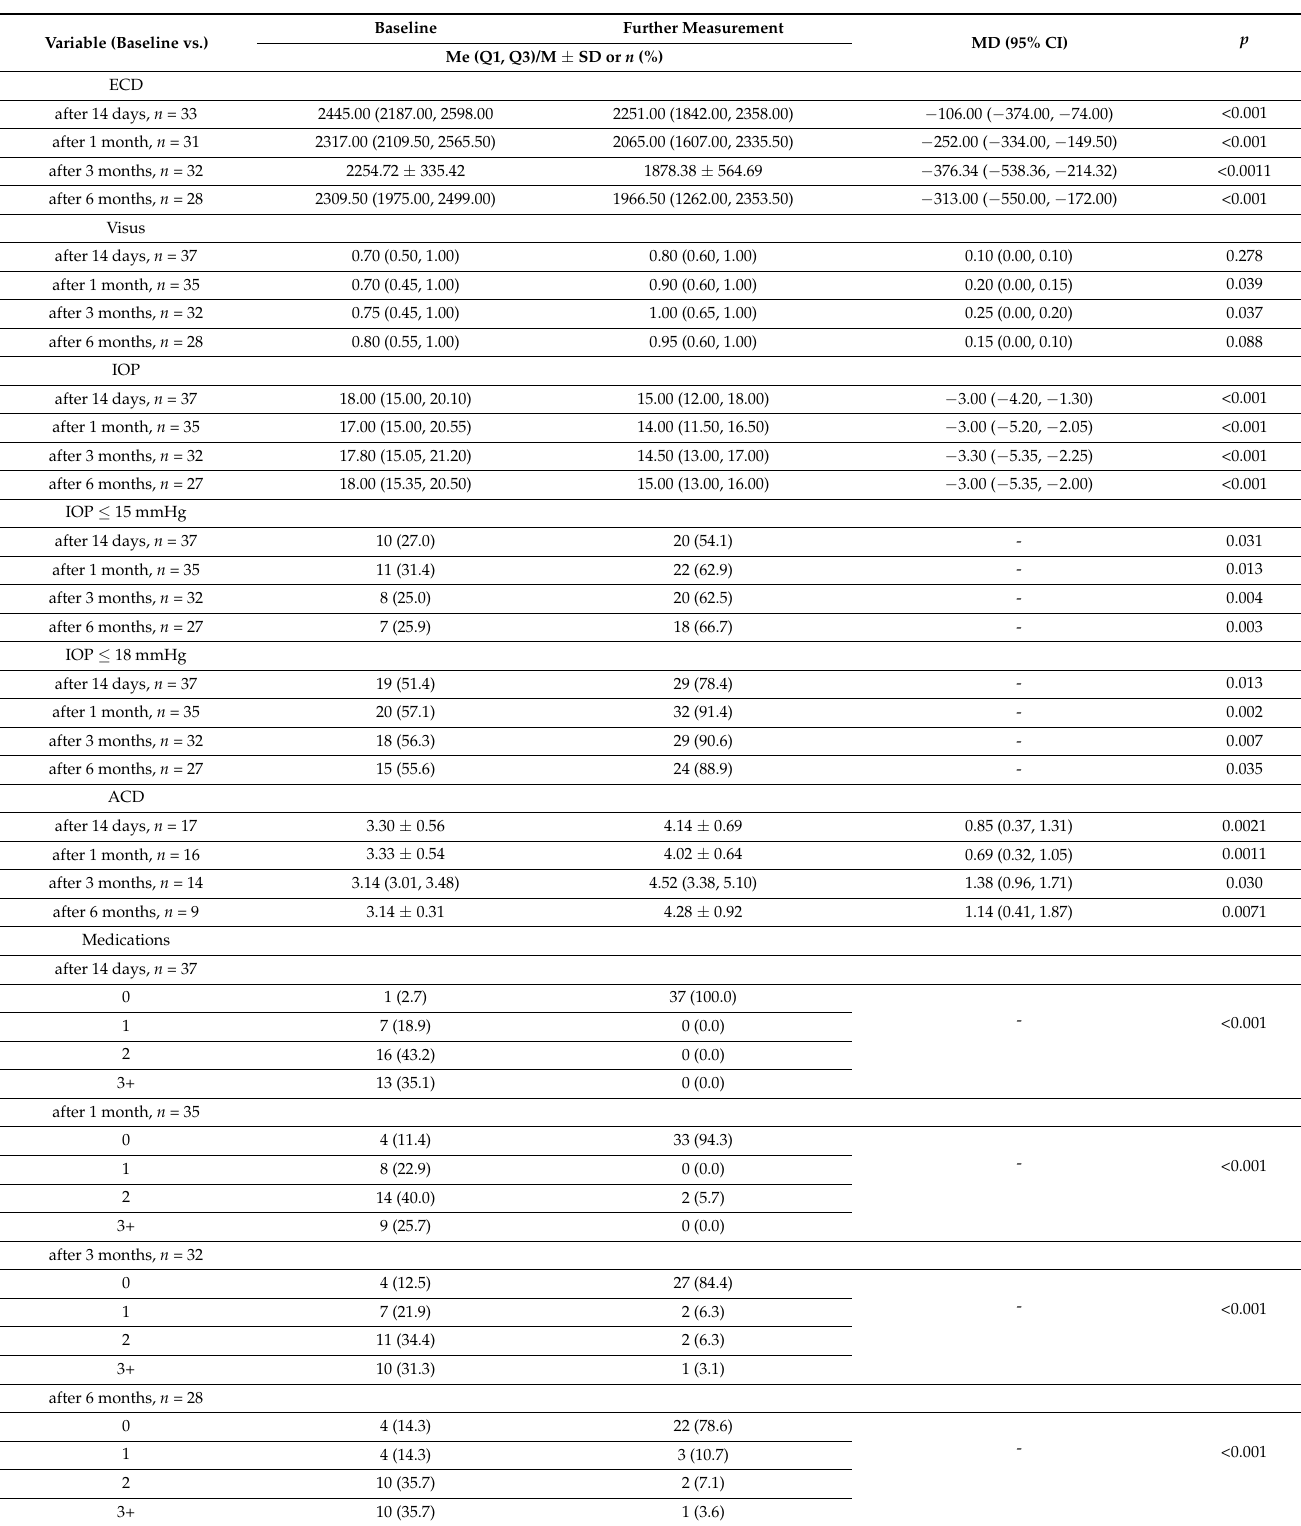
Table 6. Comparison of selected characteristics: baseline vs. further measurements (PC